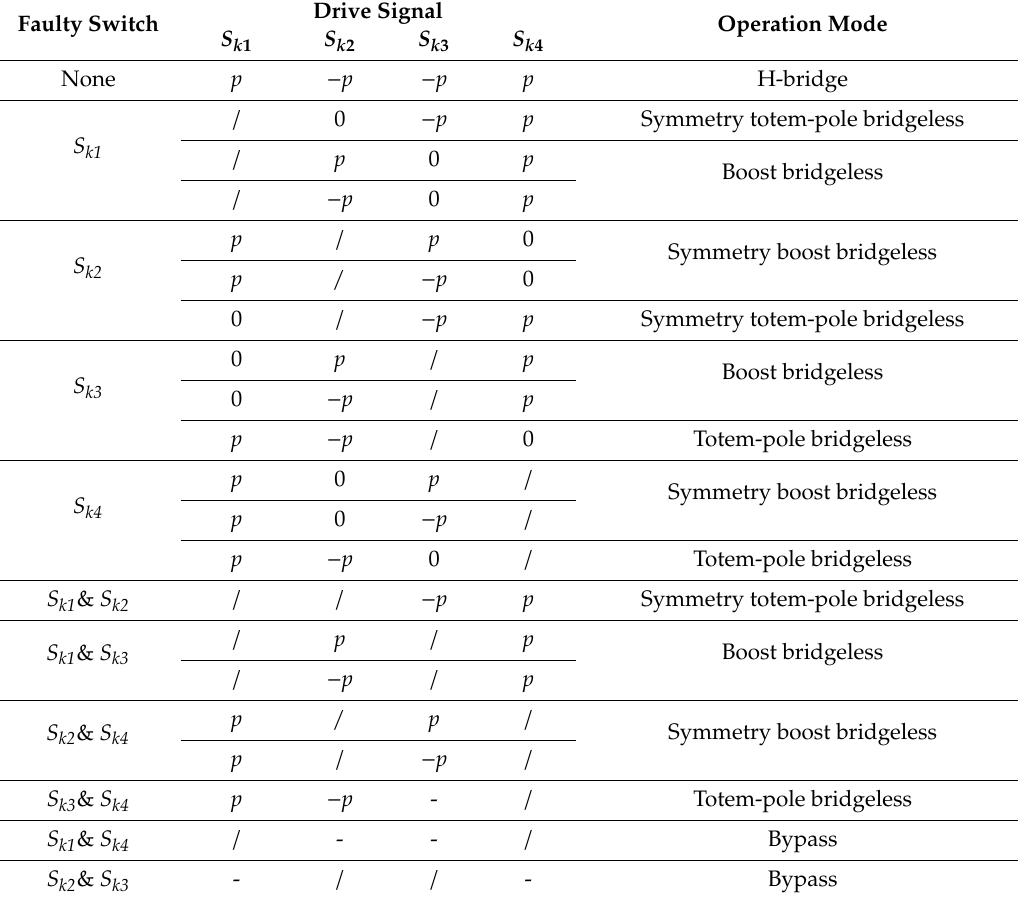
Table 1. Drive signal allocation and operation mode of di ff erent faulty switches. Faulty